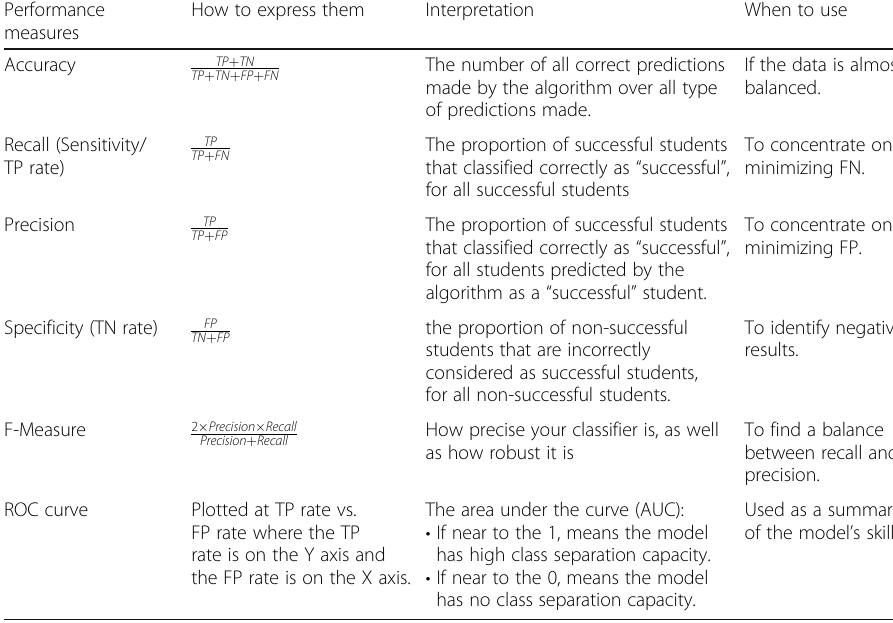
Table 15 Performance Metrics for classification problem Performance